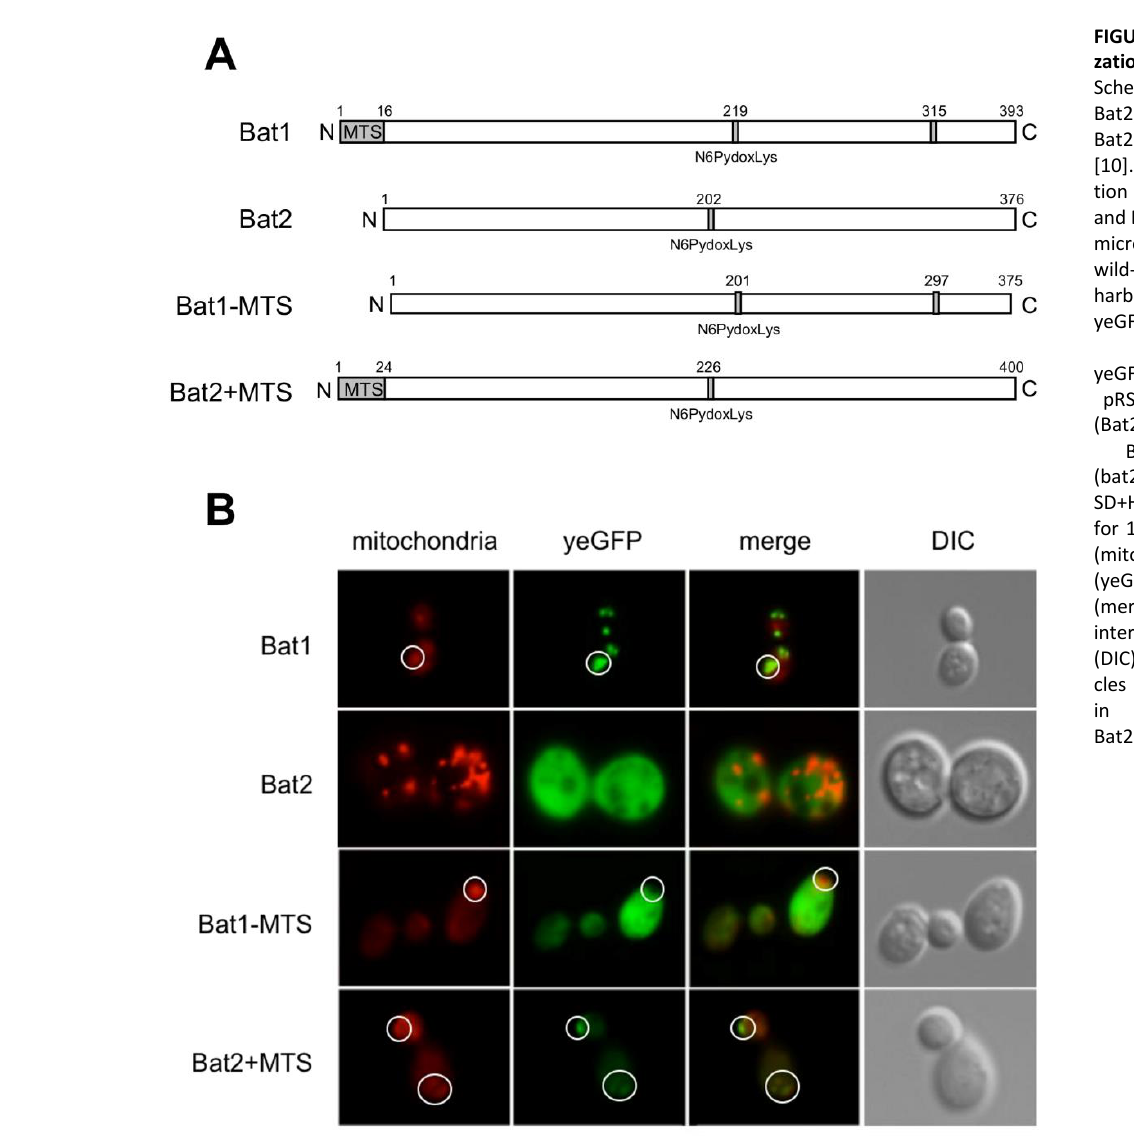
FIGURE 2: Subcellular locali- zation of Bat1 and Bat2. (A) Schematic structure of